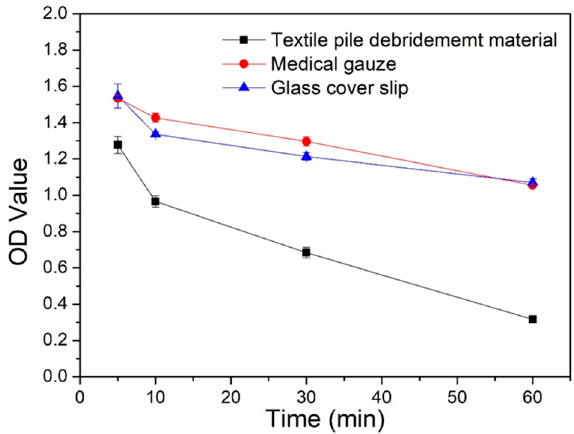
Figure 10. OD values of the coagulation assay for different samples.